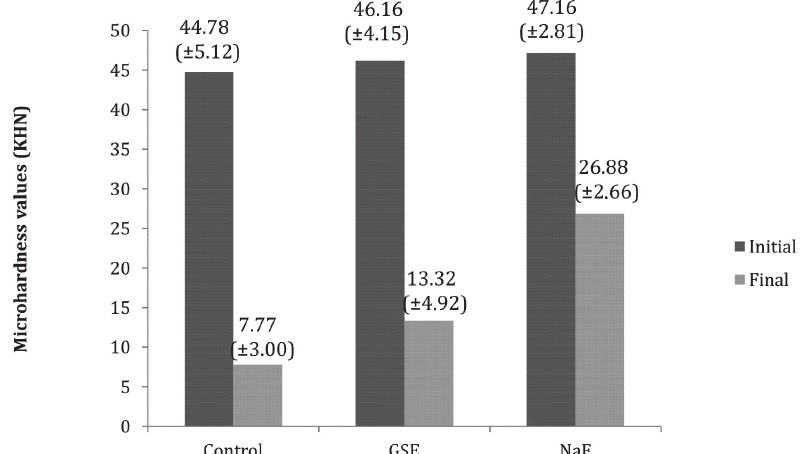
Figure 5- Means and standard deviation of dentin surface hardness (KHN) according to the different groups before